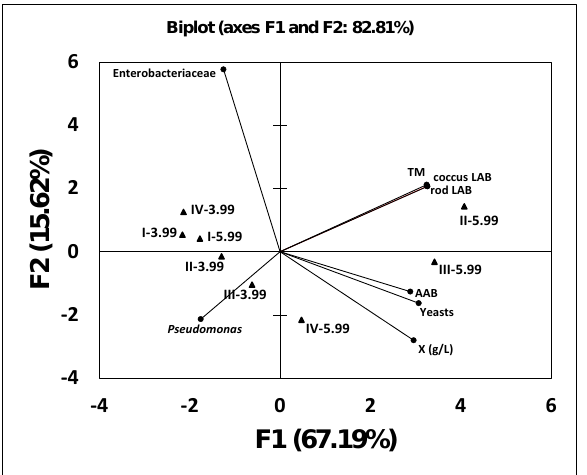
Figure 3. Principal component analysis store plot based on the differences between the microbial counts in the fermented red table grape beverages obtained from fed-batch fermentations A (I − 3.99, II − 3.99, III− 3.99 and IV − 3.99) and B (I − 5.99, II − 5.99, III− 5.99 and IV − 5.99). TM: counts of total mesophilic bacteria, LAB: lactic acid bacteria, AAB: acetic acid bacteria, X: free biomass concentration.